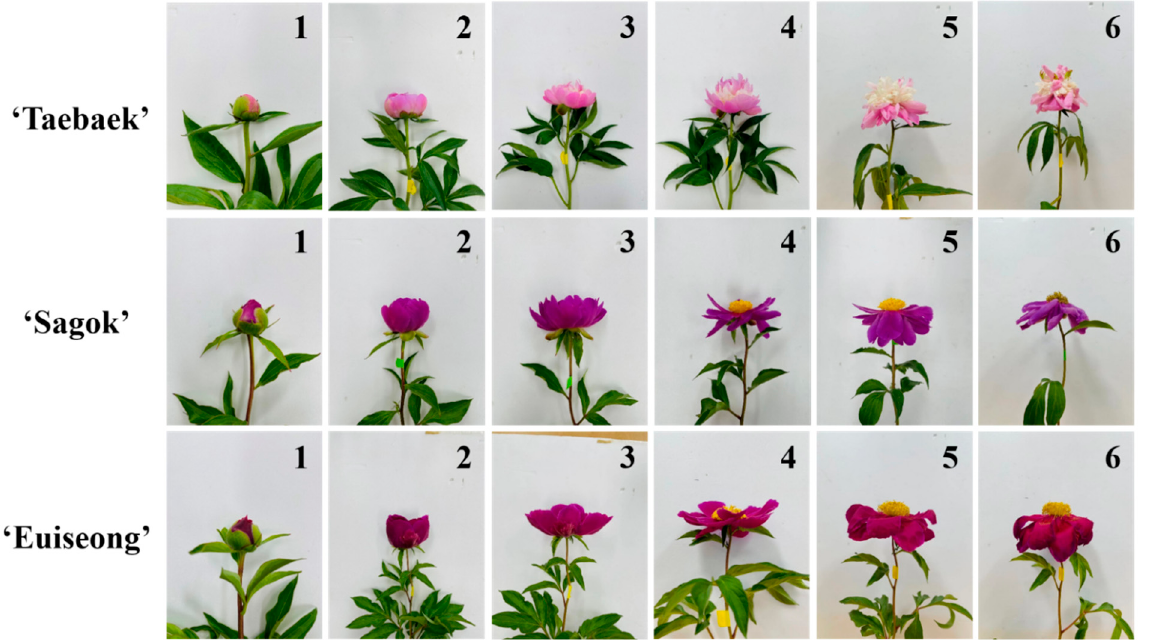
Figure 2. Six postharvest stages of cut peony flowers ‘Taebaek’, ‘Sagok’, and ‘Euiseong’. 1, ‘Marble- like stage’ or ‘Opening-engaged stage’. 2, ‘Initial-opening stage’. 3, ‘Half-opening stage’. 4, ‘Full- opening stage’. 5, ‘Petal-wilting stage’. 6, ‘Petal-falling stage’ or ‘Pistil-wilting stage’.